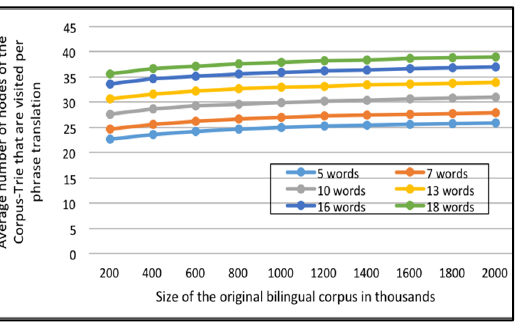
Figure 7. Average number of nodes of the Corpus-Trie that are visited per phrase translation versus Size of the original bilingual corpus in thousands, for the English-Arabic corpora.